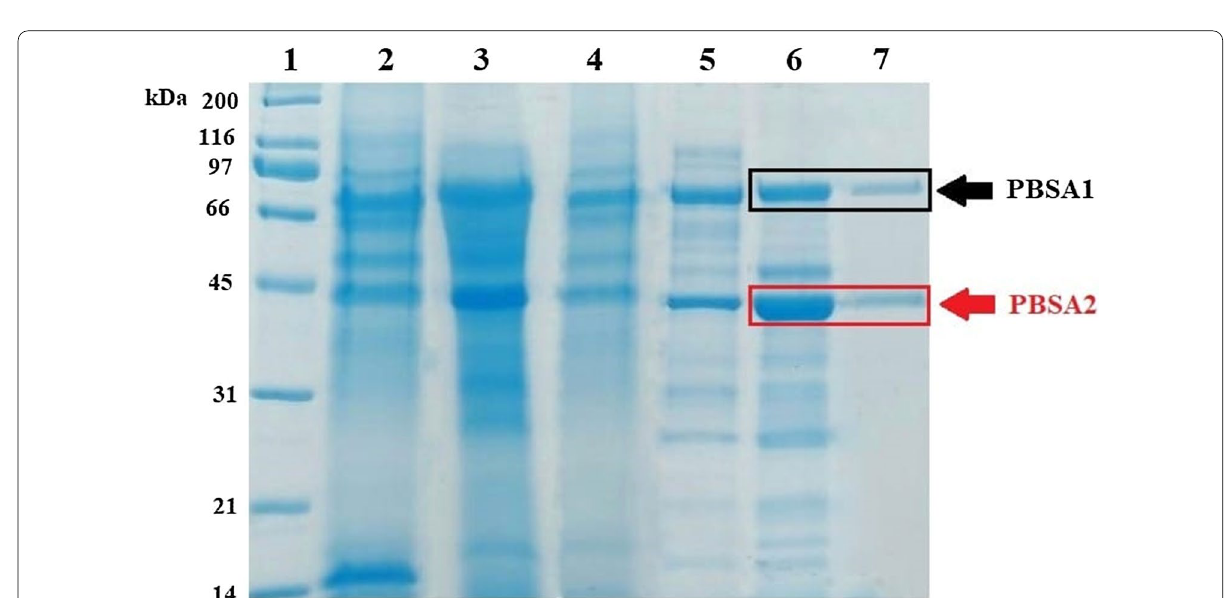
Fig. 3 Electrophoretic profile of proteins. Lane 1—molecular weight standard (Unstained SDS-PAGE Broad Range Standard, Bio-Rad); lane 2— free-cell supernatant; lane 3—60% AS fraction; lane 4—pooled fractions (wash gradient) exhibiting the activity after the first round of IEC; lane + 5—pooled wash fractions after the second round of IEC; lane 6—pooled fractions after the third round of IEC; lane 7—fraction 6 after the third round of IEC showing only two bands and biodegradation activity. PBSA1—hydrGB10I,